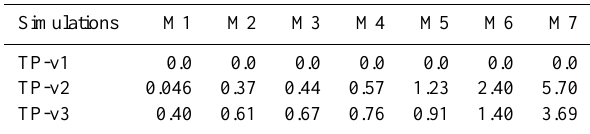
Table 4. Ratio of accumulated melt water to accumulated precipita- tion (%) at the time of peak precipitation intensity for tropical marin simulations. Values greater than 100% indicate that a greater mass of melt water has been produced in the cloud than has reached the surface as